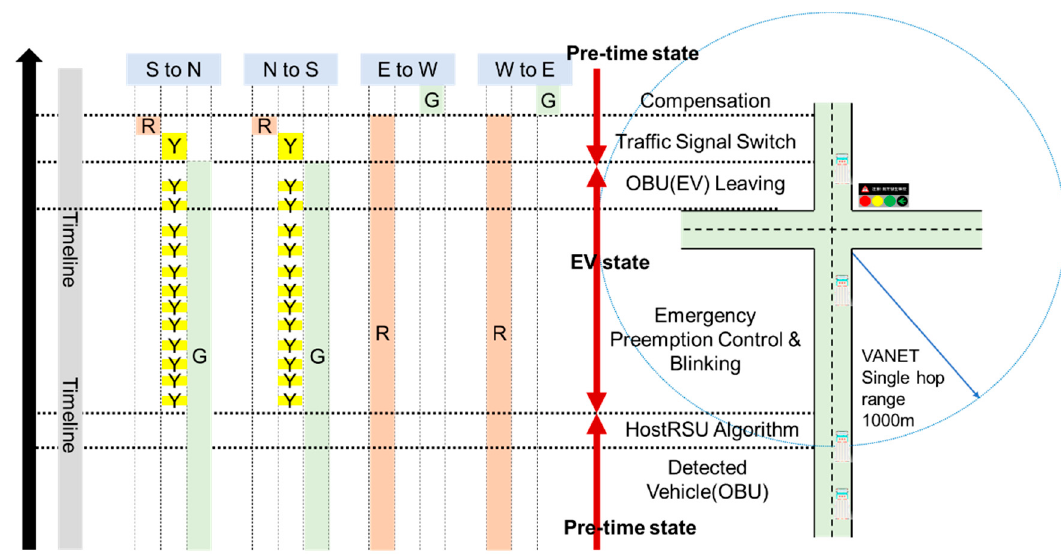
Figure 11. Traffic signal blinking mode (𝐺 (cid:3040)(cid:3042)(cid:3031)(cid:3032) ) . Figure 11. Tra ffi c signal blinking mode ( G